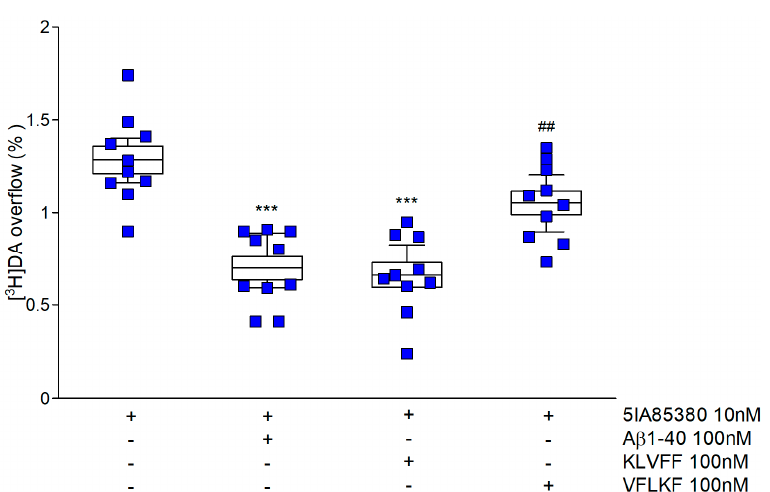
Figure 2. KLVFF counteracts the 5IA85380-induced [ 3 H] dopamine overflow from striatal synapto- somes: comparison with full-length peptide and scramble fragment. Data are mean ± SEM ( n = 6 per group). *** p < 0.001 (compared to 5IA85380); ## p < 0.01 (compared to 5IA85380 plus KLVFF) one-way ANOVA followed by Tukey’s post hoc test.